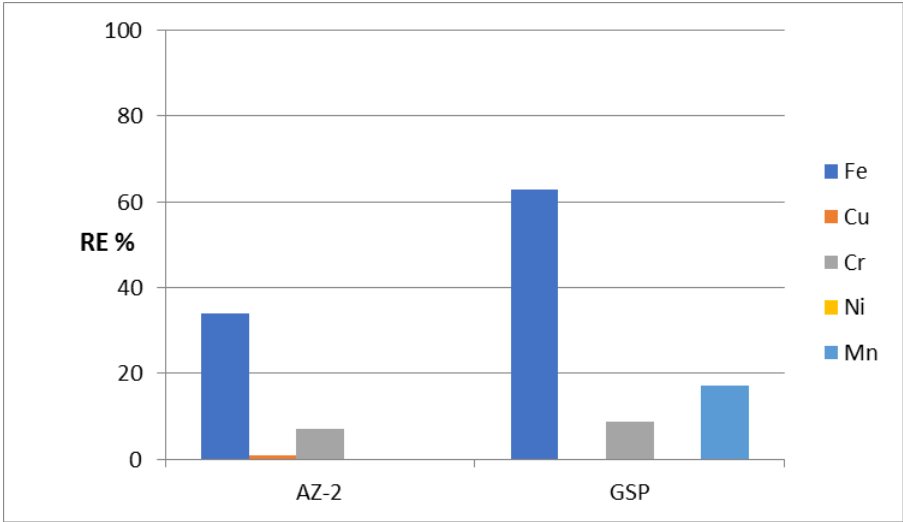
Figure 7. The removal percentage of heavy metals from water in an extremely acidic medium for the AZ-2 and GreensandPlus samples. AZ-2 and GreensandPlus